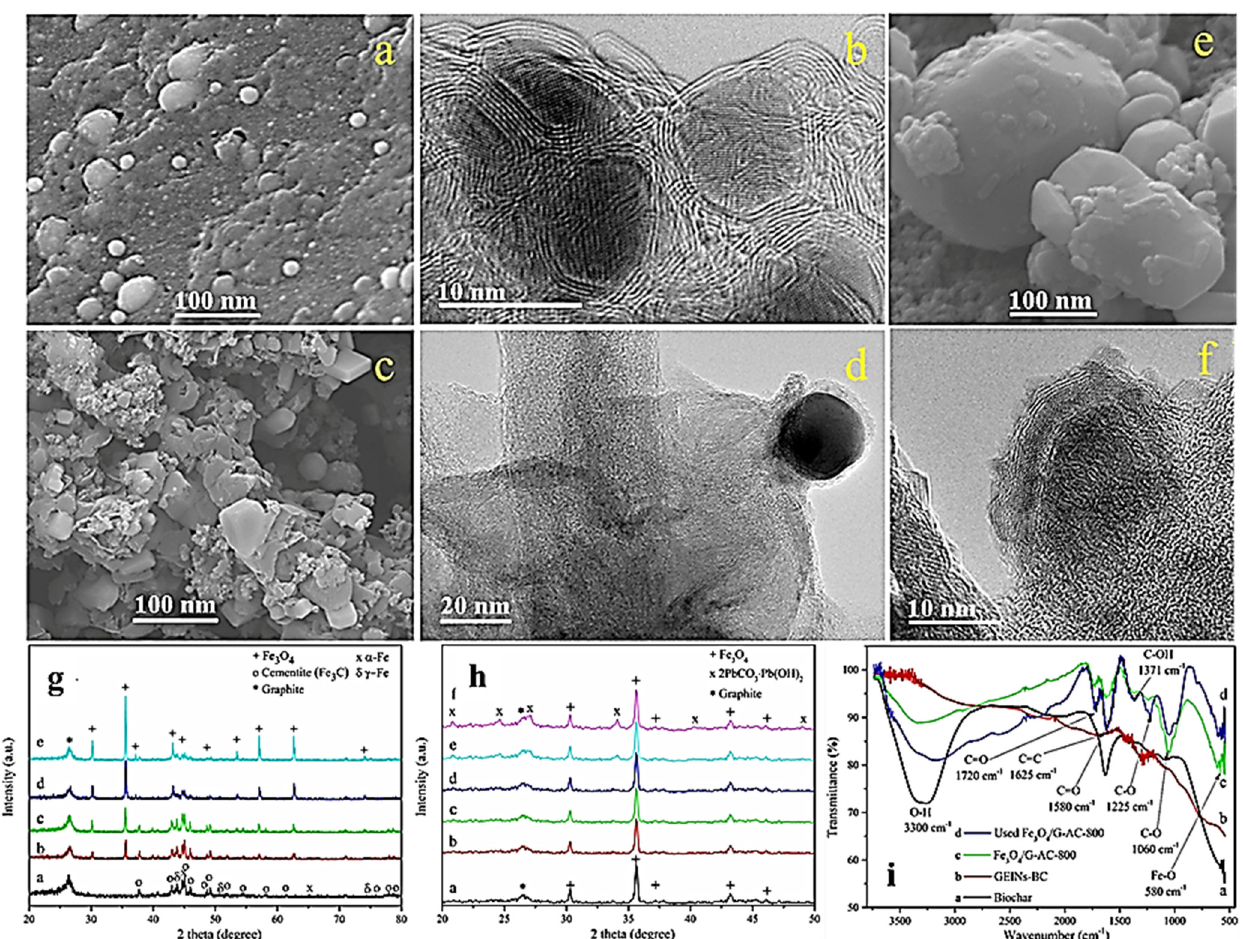
Figure 20. SEM micrographs of GEINs-BC ( a ), HRTEM micrographs of GEINs-BC ( b ), SEM image of Fe 3 O 4 /G-AC-800 ( c ), and HRTEM micrographs of Fe 3 O 4 /G-AC-800; ( d ) SEM ( e ) and HRTEM ( f ) images of Fe 3 O 4 /G-AC-800 after adsorption at pH of 5. XRD patterns ( g ) of graphene-enclosed iron nanoparticles in biochar (GEINs-BC, a ) and Fe 3 O 4 /G-AC ( b – e ) samples activation of GEINs-BC under steam at various temperatures (500, 600, 700, and 800 °C). XRD profile ( h ) of Fe 3 O 4 /G-AC-800 ( a ) before/after adsorption of Pb(II) solution with numerous pH values: pH = 3 ( b ), pH = 4 ( c ), pH = 5 ( d ), pH = 6 ( e ), and pH = 7 ( f ); FTIR profile of biochar ( i ) ( a ), GEINs-BC ( b ), and Fe 3 O 4 /G-AC-800 ( c ) before/after Pb(II) ions adsorption ( d ). Reproduced with permission from [186].